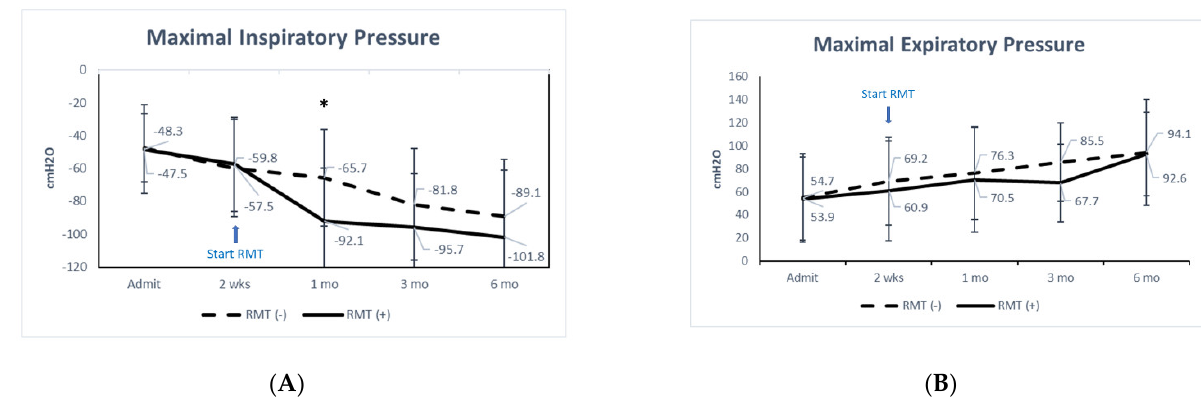
Figure 1. ( A ) Maximal inspiratory pressure and ( B ) maximal expiratory pressure (present with mean and standard derivation) at admission, two weeks, one month, three months, and six months in patients who received or did not receive RMT. * p < 0.05, by two-way repeated measures ANOVA.